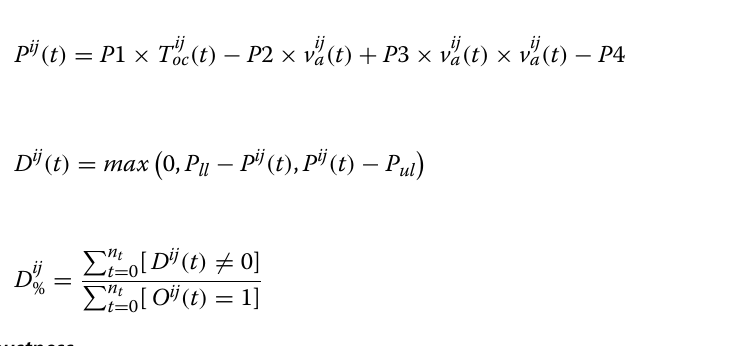
else uncomfortable. D ij denotes the percentage of time instances in a day when the user % was uncomfortable in the